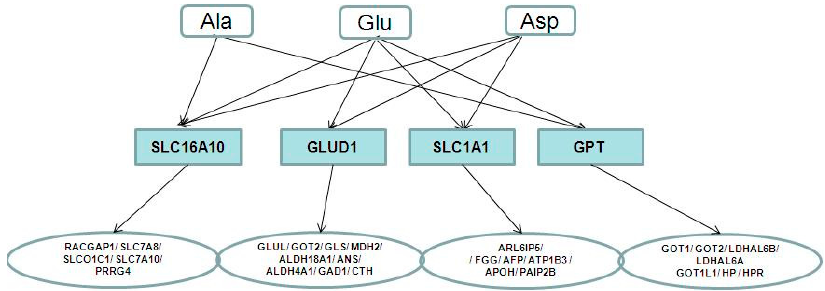
Figure 6. The three metabolites associated with stroke-related proteins . Metabolites, enzymes and proteins are represented with rounded rectangles, rectangles and ellipses, respectively.